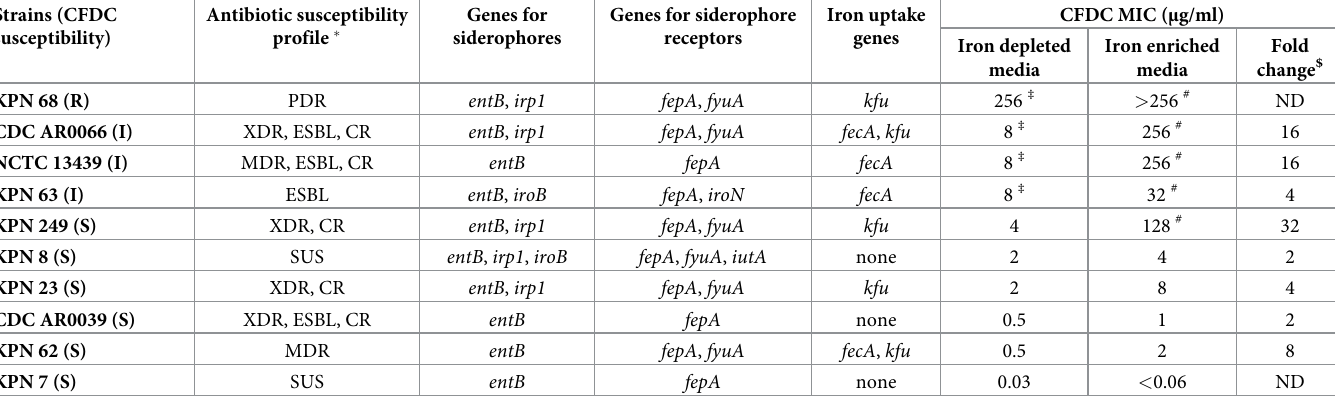
yersiniabactin receptor ( fyuA ). The presence of kfu with fyuA , even without fecA , also caused a significant increase in CFDC MICs in some strains. Gene expression Gene expression (GE) of siderophores, siderophore receptors and iron transport genes was assessed in 10 strains, including CFDC resistant (R; n = 1), intermediately susceptible (I; n = 3), and susceptible (S; n = 6) strains. Table 4 is a list of the strains used in GE and their properties. GE in iron enriched media and CFDC treated cultures were compared and normalized to expressions detected in iron depleted media at the same time point of treatment. Folds change Table 4. Strains tested for gene expression and their properties including genes encoding iron acquisition systems and CFDC MICs in iron depleted and iron enriched media. Strains (CFDC Antibiotic susceptibility susceptibility) profile